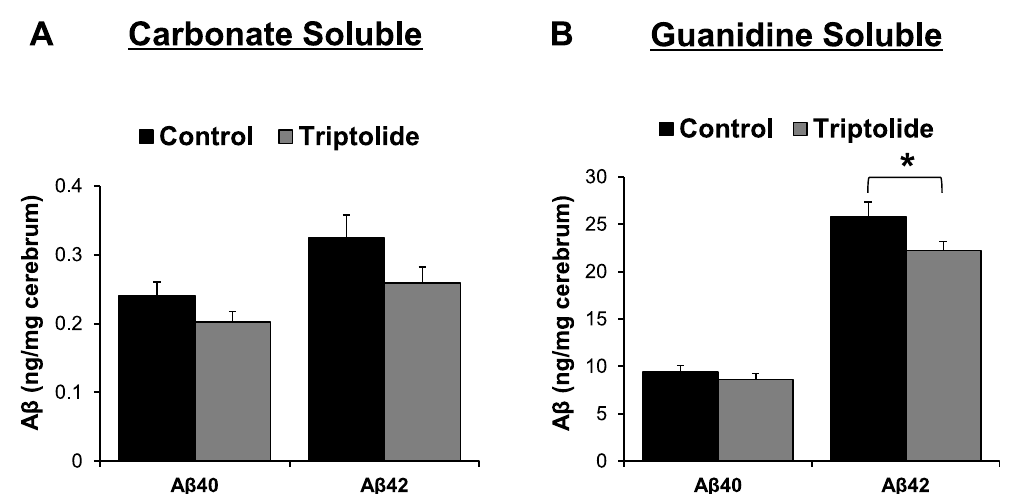
Figure 3. Triptolide treatment reduces cerebral A b levels in APP/PS1 mice. Carbonate-soluble ( A ) and carbonate-insoluble (guanidine- soluble) ( B ) A b 40 and A b 42 levels in cerebral homogenates were measured by ELISA. A , There was a trend for a reduced level of carbonate-soluble A b in triptolide-treated mice, but the difference did not reach statistical significance. B , Significant reductions in the levels of guanidine-soluble A b 42 were observed in triptolide-treated mice. N=7 mice/group; Age=8.6 months; *, P ,